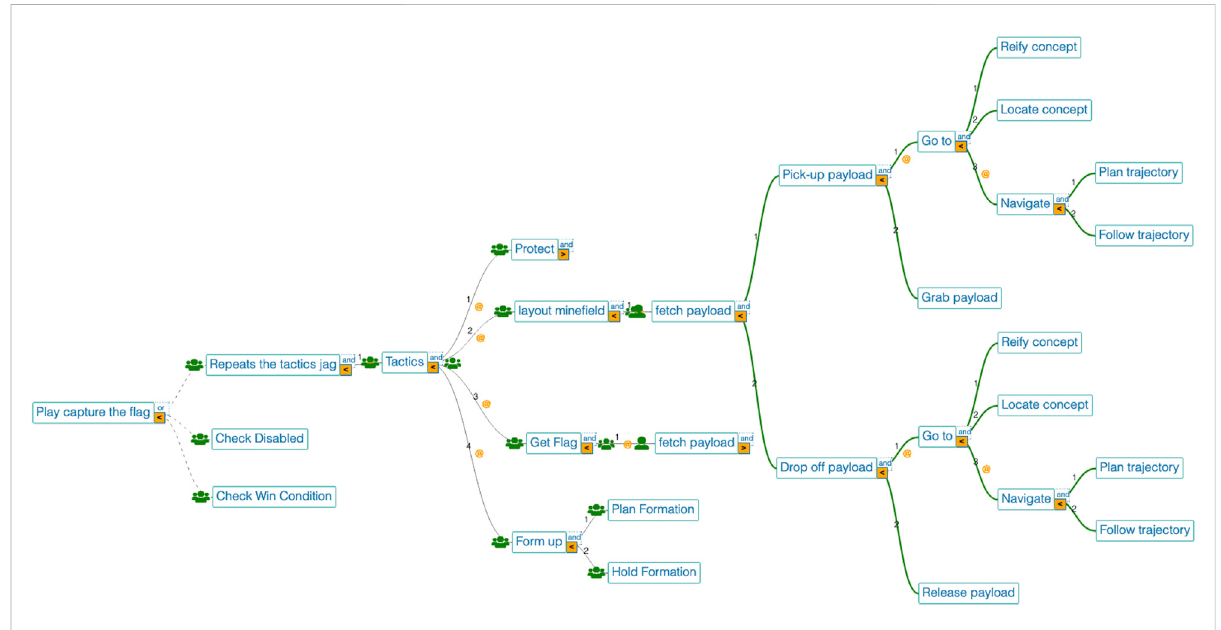
FIGURE 5 Joint activity graph for the Capture-the-Flag scenario - semi